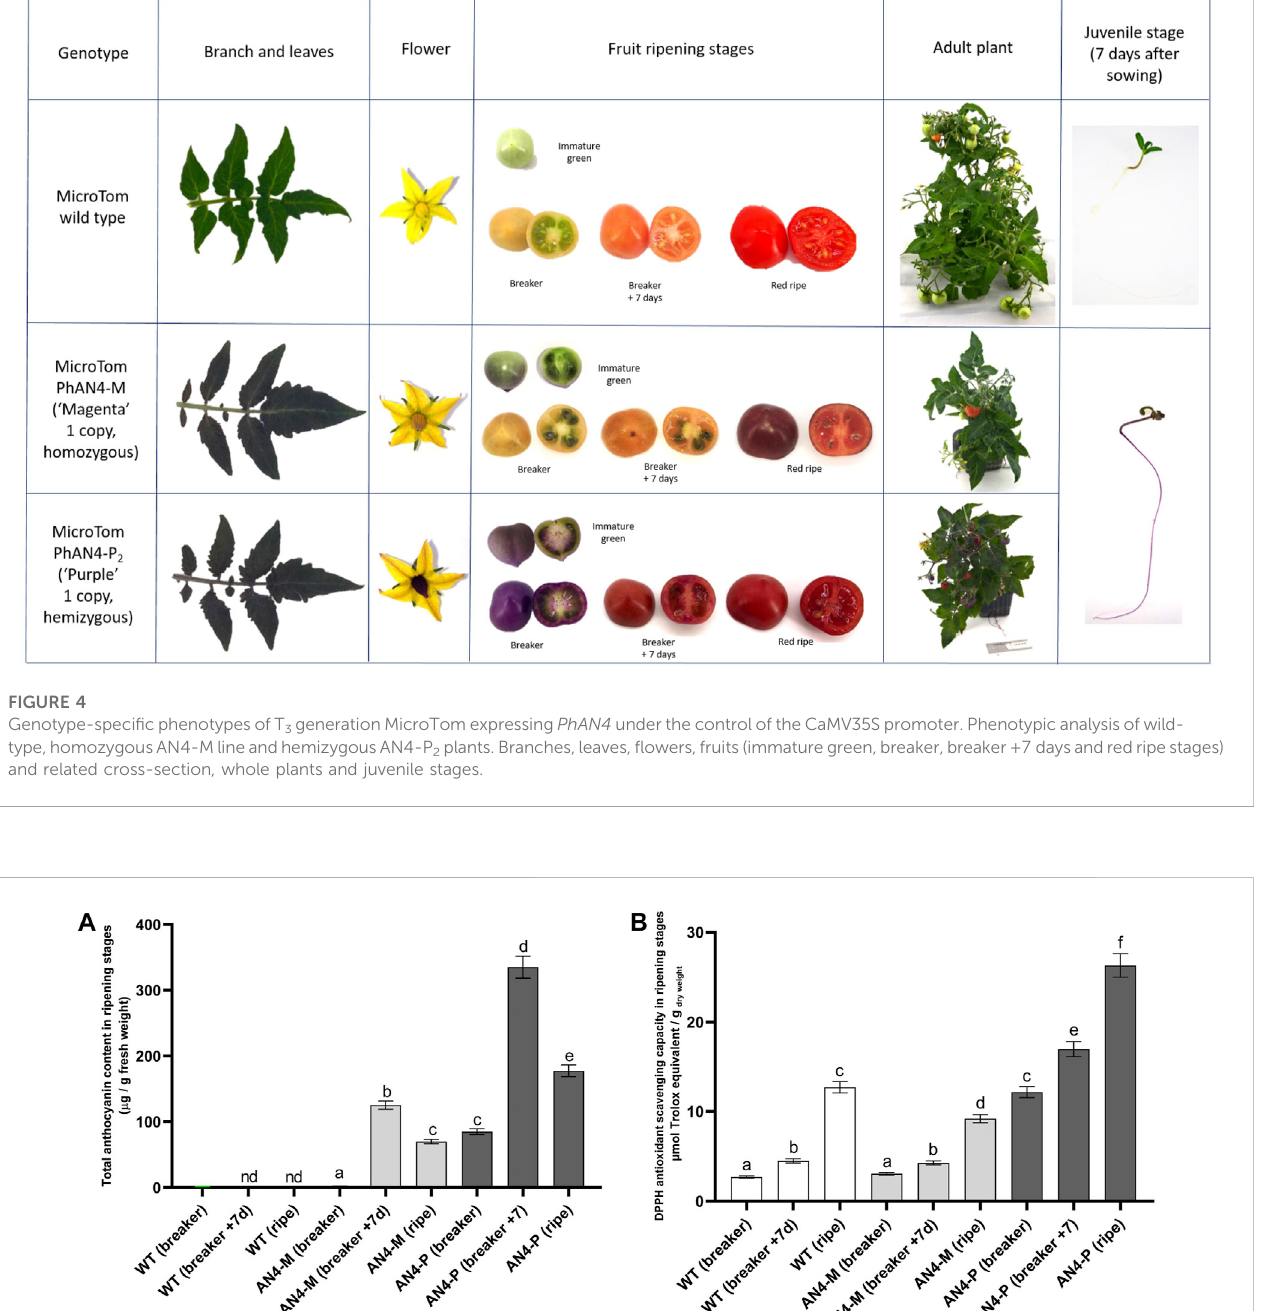
in AN4-M ( Δ h = 162.46) (Figure 6A). The ESR spectra and the maximum intensity (h) reached by radicals ’ accumulation upon 2 kGy irradiation for AN4-P 2 and wild type are substantially equivalent in correspondence of radical referring to the g = 2.020 ( Δ h = − 232.96), whereas they differ for the g = 2.014 singlet with AN4-P 2 showing a